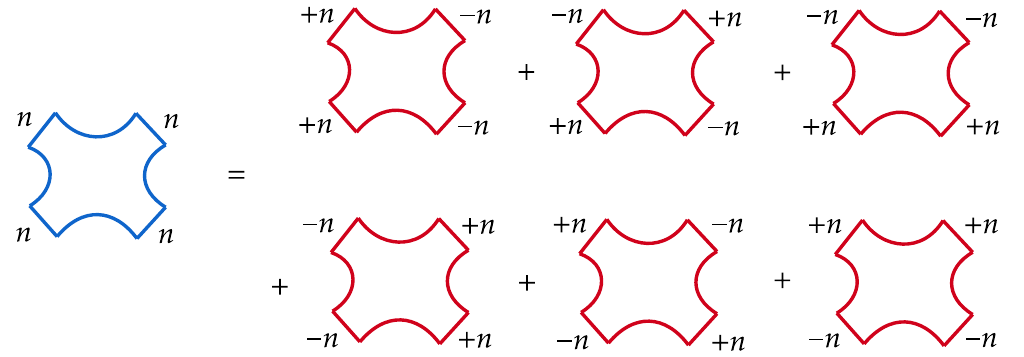
Figure 1 . Elastic scattering amplitude of ( n, n ) → ( n, n ) for massive KK open strings with Z parity (blue color) can be decomposed to a sum of six sub-amplitudes of massive KK open strings (red color) under the S 1 compactification of 26d for bosonic